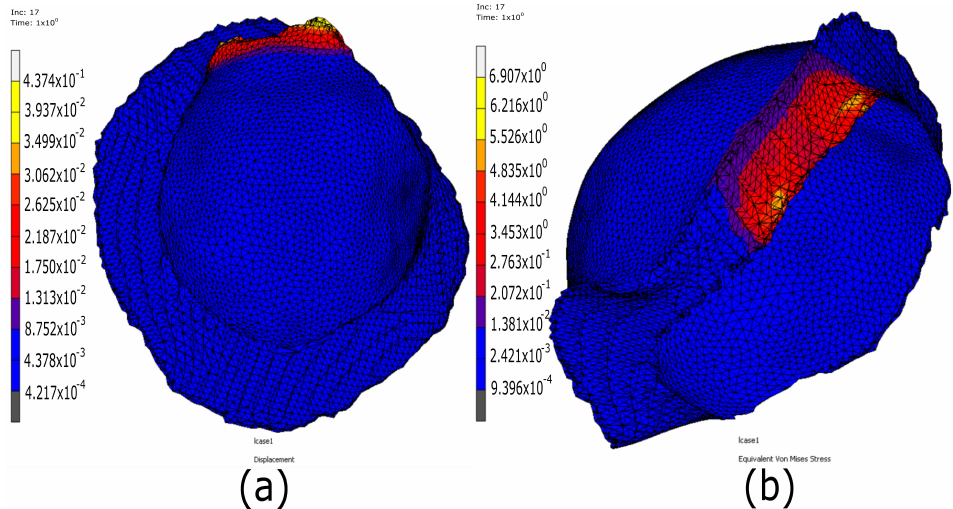
Figure 8. FE results for the cartilage of the Cam-type femoroacetabular impingement hip joint: ( a ) displacement and ( b ) von Mises